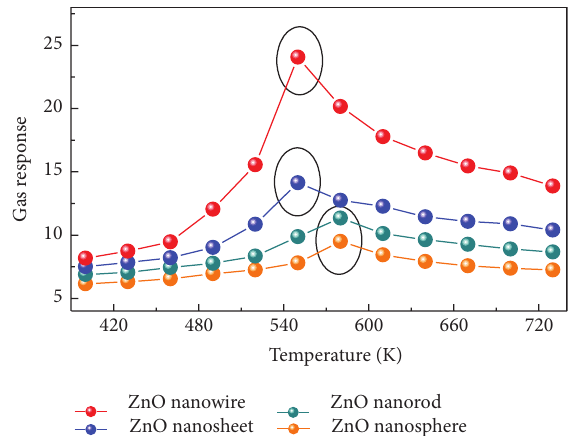
Figure 5: Gas response of the sensors to 20 𝜇 L/L of C 2 H 2 gas as a function of operating temperature ranging from 400K to 730 K.